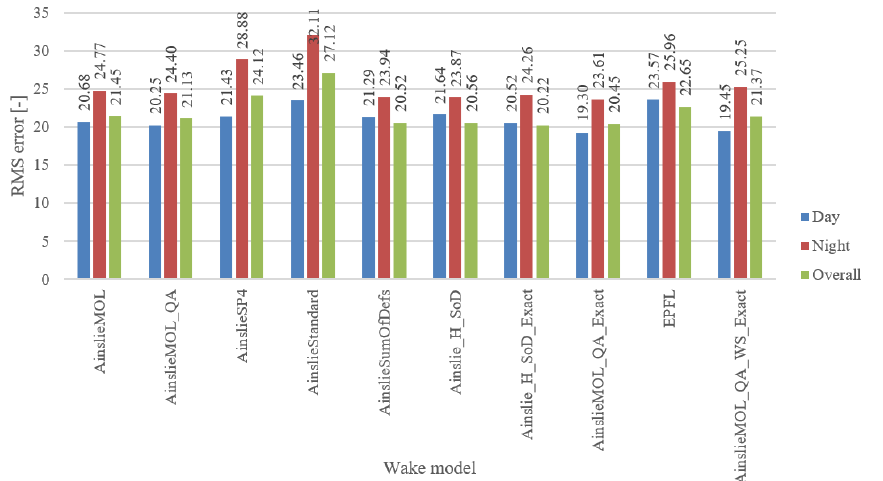
Figure 4. Overall comparison of different wake